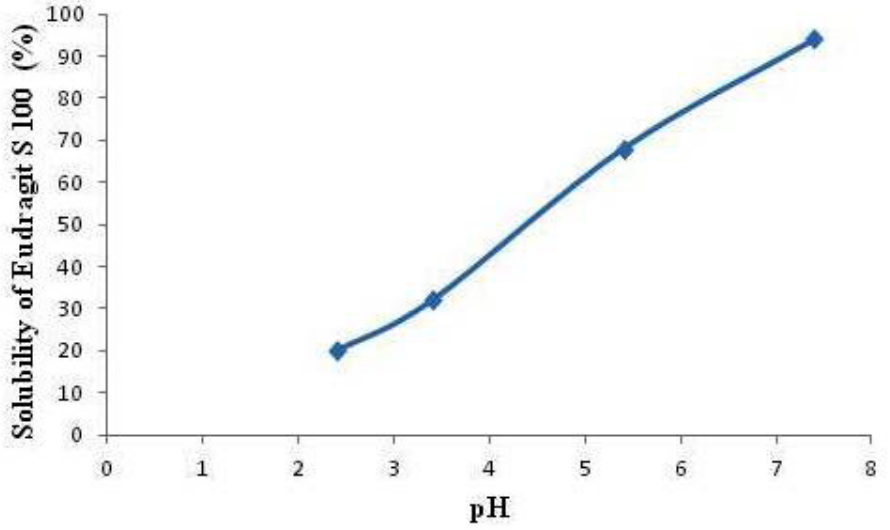
FIGURE 3 - % Solubility of Eudragit S 100 at different pH.